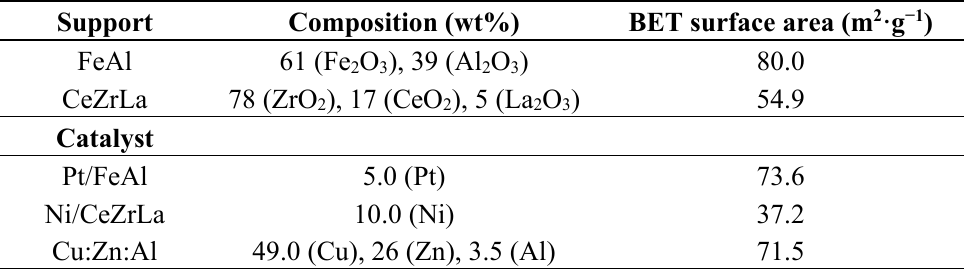
Table 1. Catalyst composition and porous